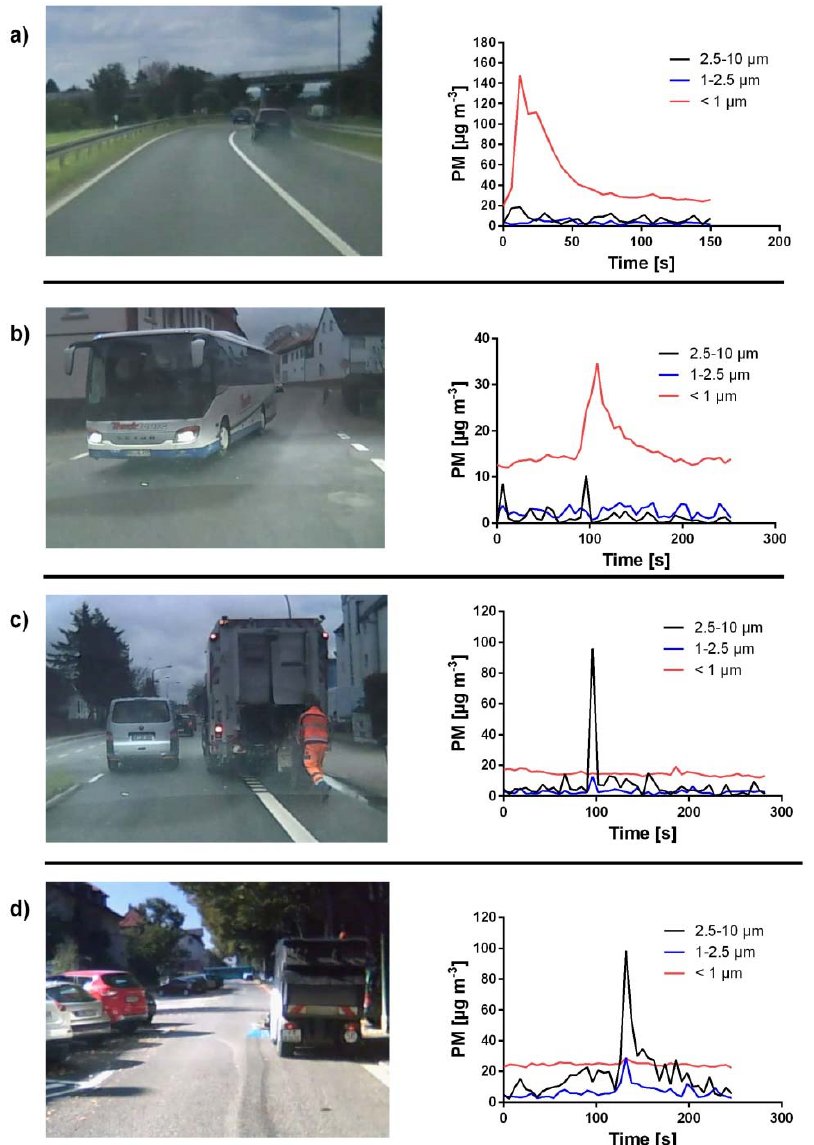
Figure 6. Different PM sources with the corresponding particle size spectrum. ( a ) A car with soot production, ( b ) a bus, ( c ) a garbage truck, ( d ) a street sweeper (see also Supplementary Material